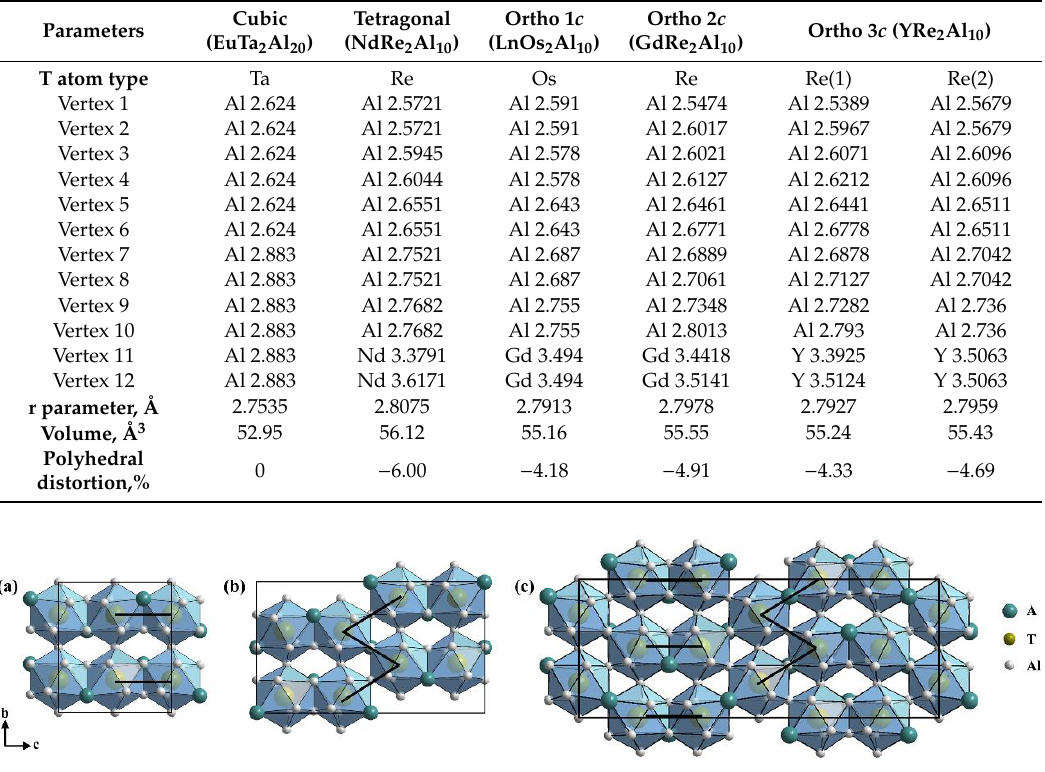
Figure 4. Chains of the interconnected icosahedrons as formed in the unit cells of three orthorhombic structures: ( a ) 1 c, ( b ) 2 c and ( c ) 3 c . Parallel rows and zigzag like chains are marked by lines in ( a ) and ( b ), respectively. In ( c ) both types of connections are seen. The illustration was prepared using Diamond commercial software.